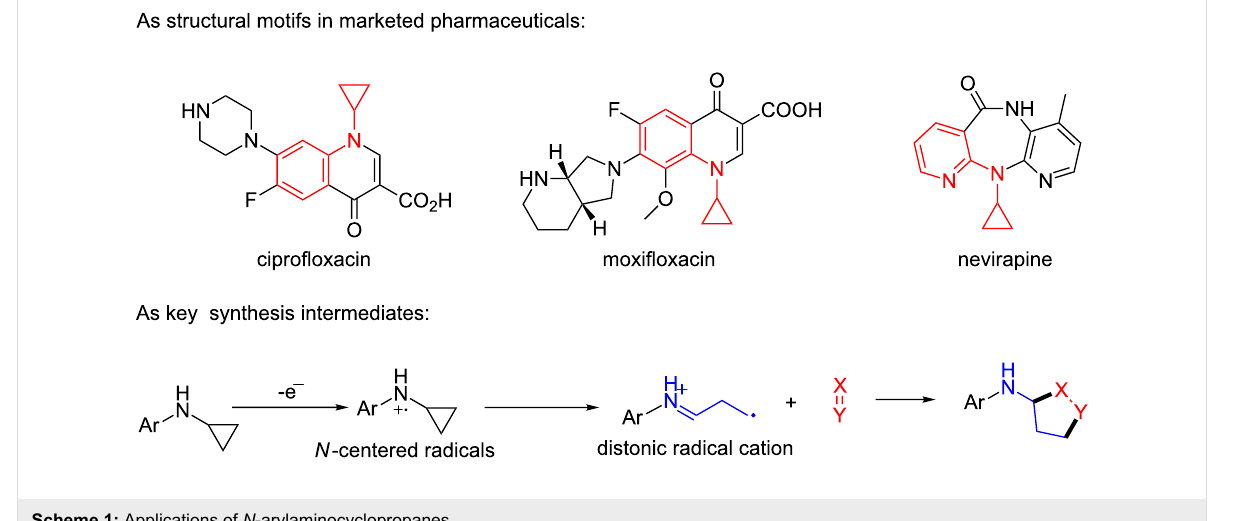
Scheme 1: Applications of N